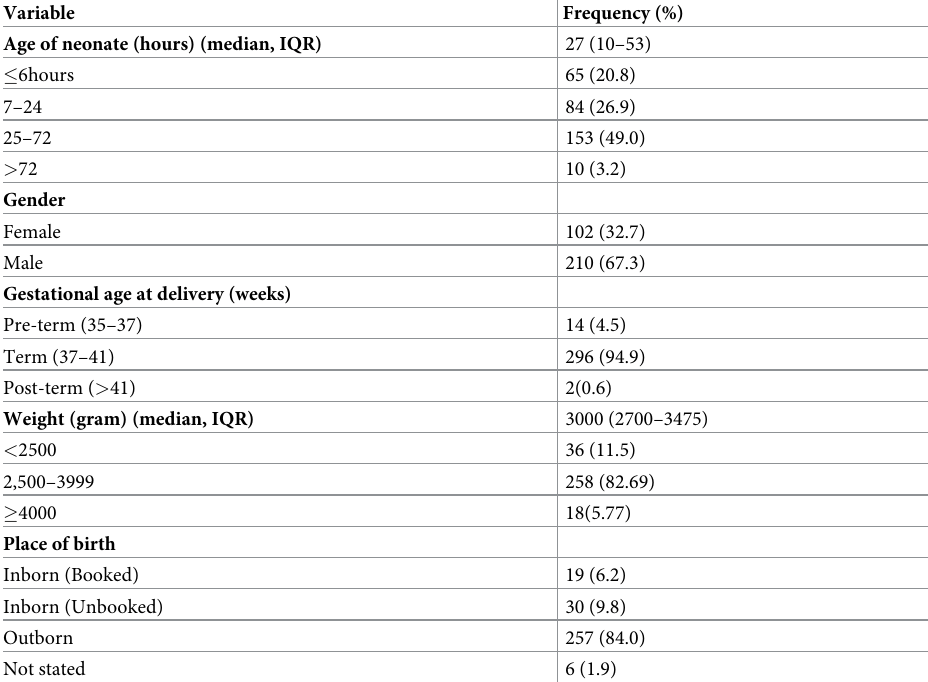
Table 1. Socio-biologic characteristics of infants with